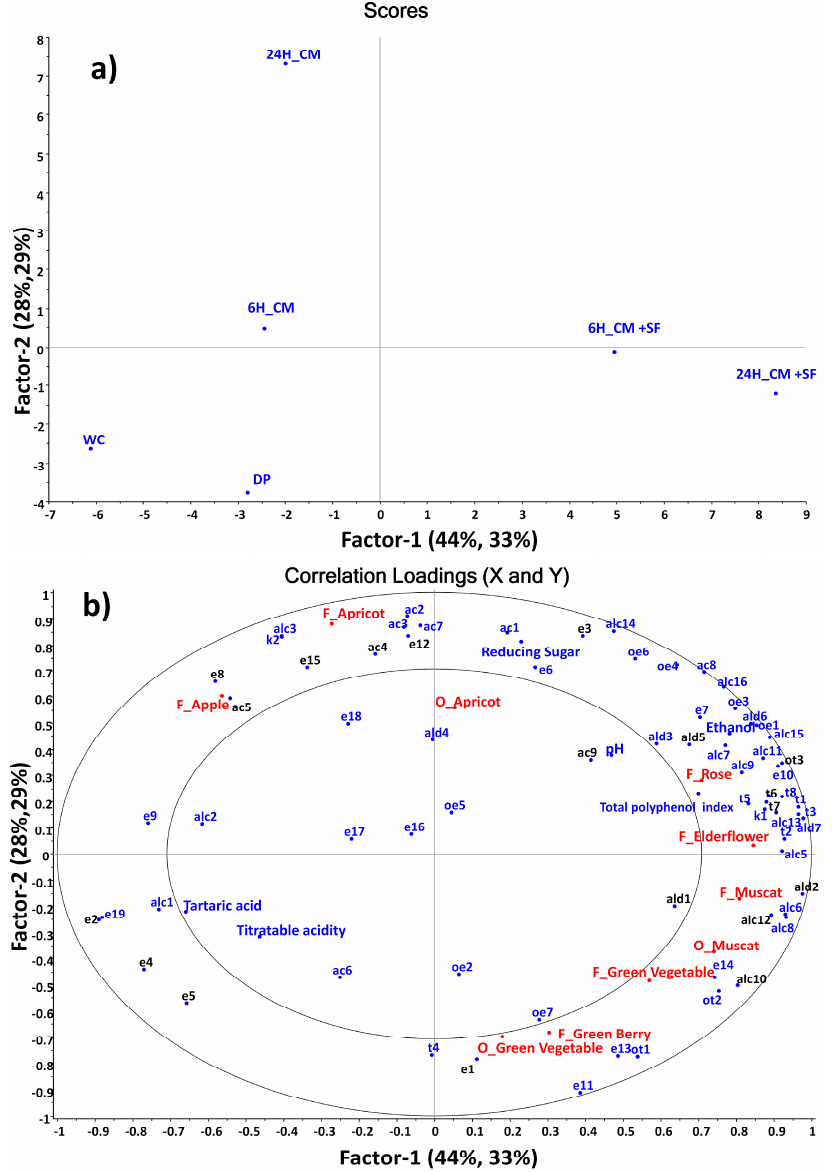
Figure 2. Partial Least Squares Regression (PLS) of wines correlation score ( a ) and loading plots ( b ) of the first two PCs. X-matrix: volatile compounds ( blue , compounds with OAV > 0.1 are in black bold), chemical parameters; Y-matrix: sensory descriptors ( red ). The inner and outer ellipses represent R 2 = 50% and 100%, respectively.